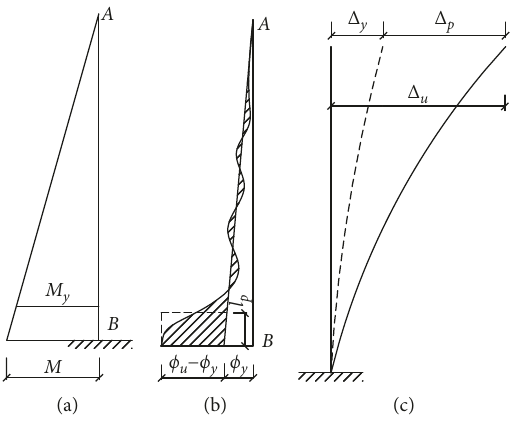
Figure 8: (a) Bending moment, (b) curvature, and (c) lateral displacement of cantilever shear